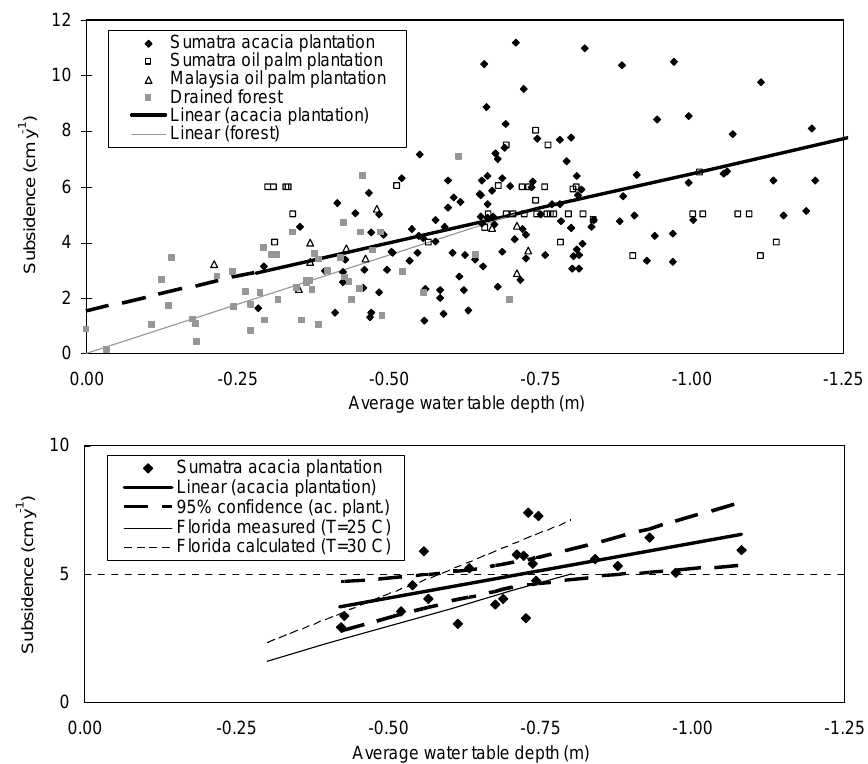
Fig. 5. Subsidence rates and water table depths as measured in Acacia plantations, oil palm plantations and adjacent forest in Sumatra, Indonesia. Top: data for individual monitoring locations. Measurements in Malaysian oil palm plantations are shown for comparison (from DID Malaysia, 1996). The linear relations shown are for Acacia plantations (excluding oil palm plantations) and forest. Bottom: averages for the Sumatra plantation data, grouped by (sub-) transects of 5 to 9 adjacent monitoring locations. Linear relations for Florida Everglades are also shown (adapted from Stephens et al., 1984). Table 2. Subsidence rates and carbon loss over different time periods, as determined from subsidence and bulk density data. Acacia plantation sites Oil palm plantation sites Plantation average Total subsidence in first 5yr (m) 1.42 – – after drainage Average subsidence and SD, > 5yr cmyr − 1 5 ± 2.2 5.4 ± 1.1 5.2 after drainage Carbon loss 0–5yr – after drainage (measured) – 119 – after drainage (measured) Carbon loss 5–8yr – – after drainage